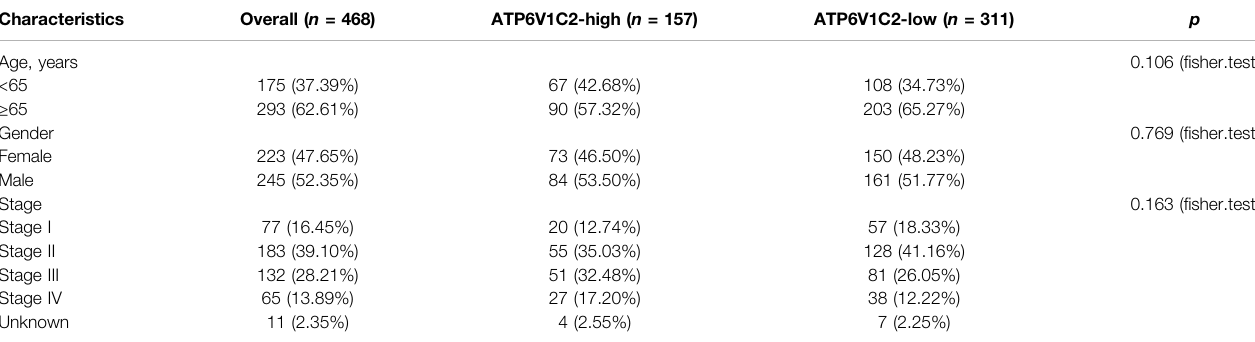
TABLE 1 | Clinicopathological characteristics of COAD patients.